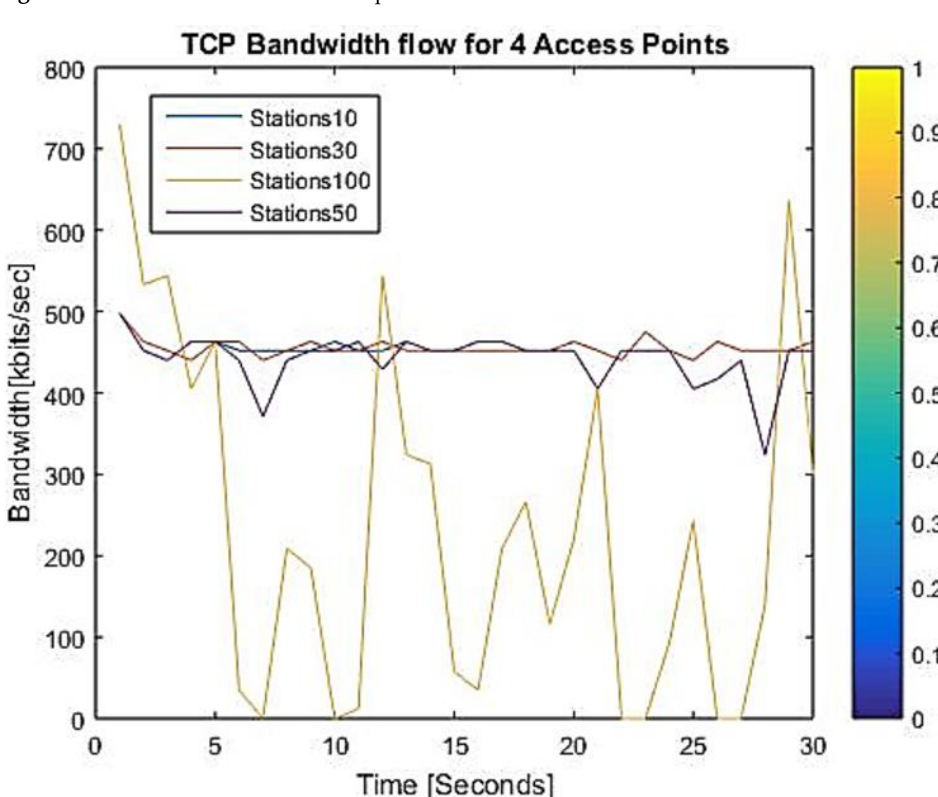
Figure 9. TCP bandwidth for 4 access points.